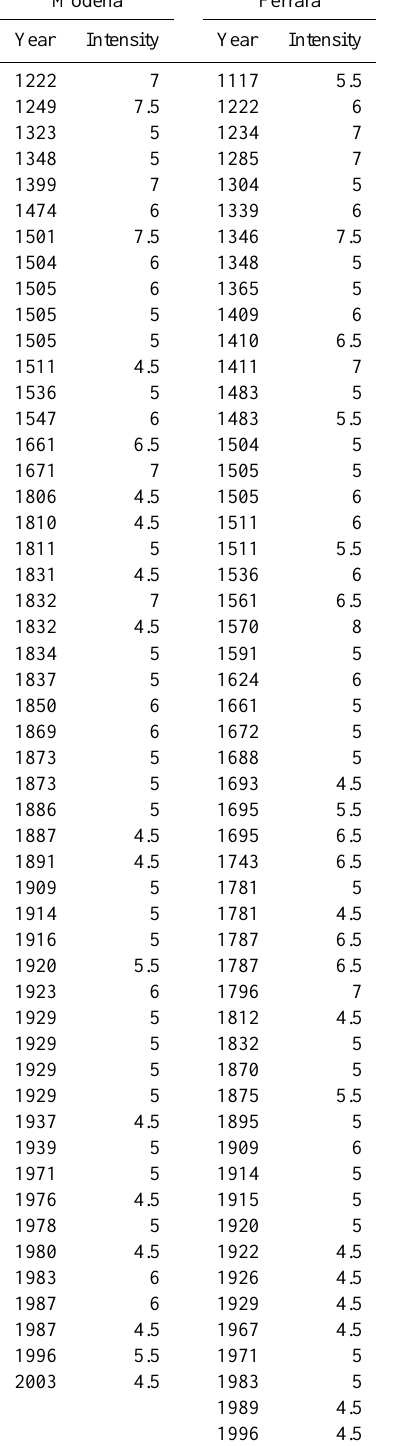
Table 2. Site seismic history for Modena and Ferrara, Italy, from the Italian Database of Macroseismic Intensities, available on the INGV website (http://emidius.mi.ingv.it/DBMI11/). Modena Ferrara